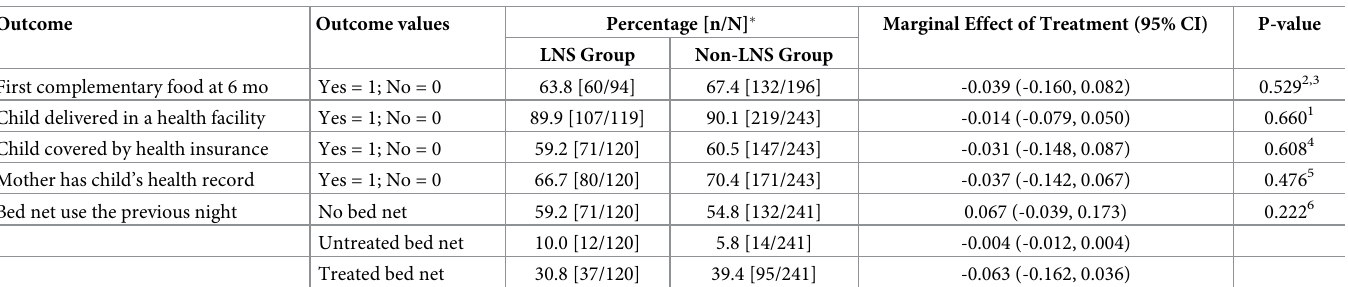
Table 6. Investments in younger siblings by intervention